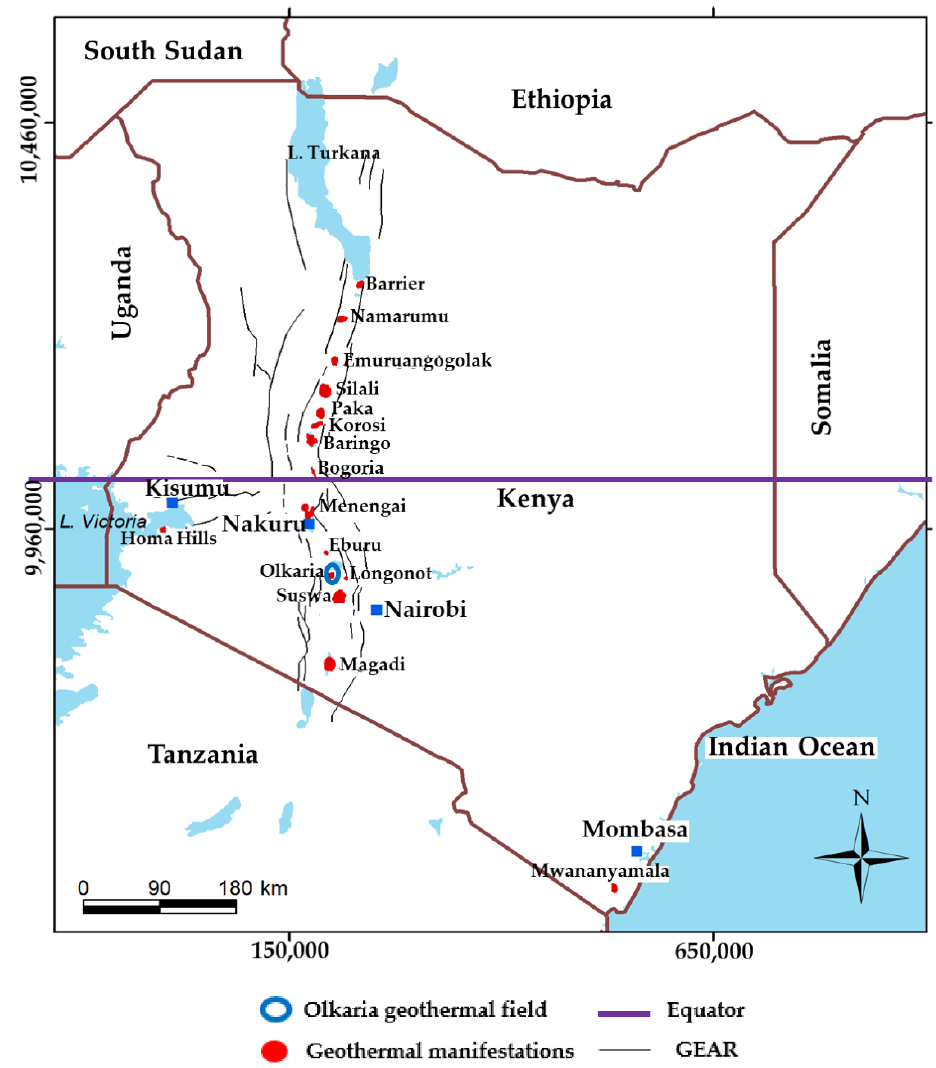
Figure 1. Map of Kenya showing geothermal manifestations along the Great East Africa Rift (GEAR) modified from [21].